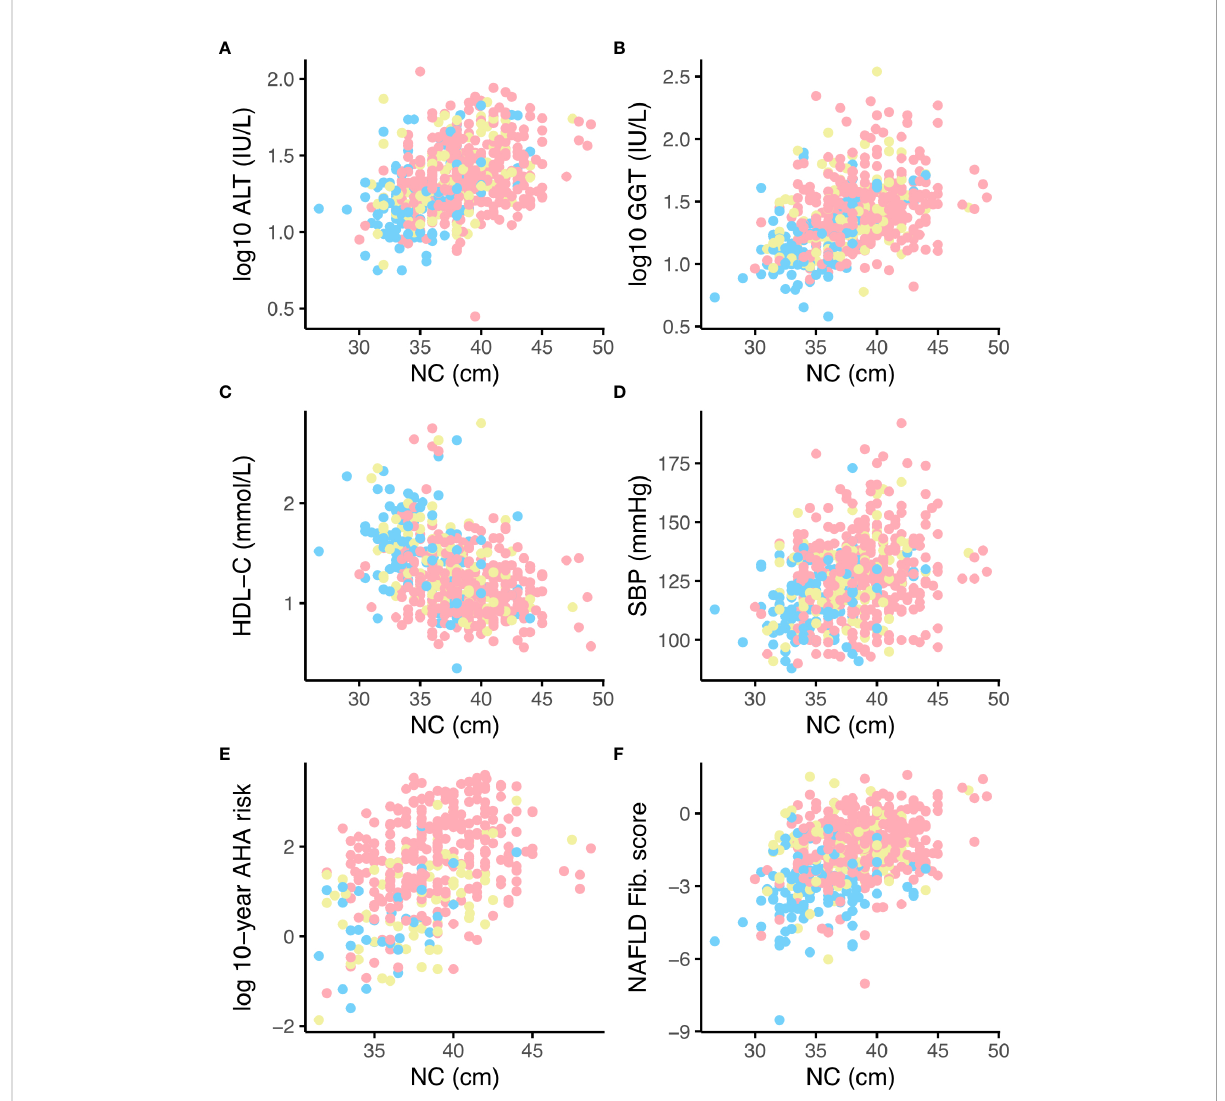
FIGURE 2 Relationships between neck circumference (NC) and liver function tests, lipid pro fi le, blood pressure, AHA 10-year cardiovascular risk and NAFLD Fibrosis score, strati fi ed by glycaemic status. NGT = blue, Prediabetes = yellow, Type 2 diabetes = pink. Panels (A) log-transformed ALT, (B) log-transformed GGT, (C) HDL-cholesterol (HDL-C), (D) systolic blood pressure (E) log-transformed 10-year cardiovascular risk assessed by AHA pooled-cohort equations, (F) NAFLD fi brosis score. ALT, alanine transaminase; GGT, gamma-glutamyl transferase; SBP, systolic blood pressure; AHA, American Heart Association; NAFLD, non-alcoholic fatty liver